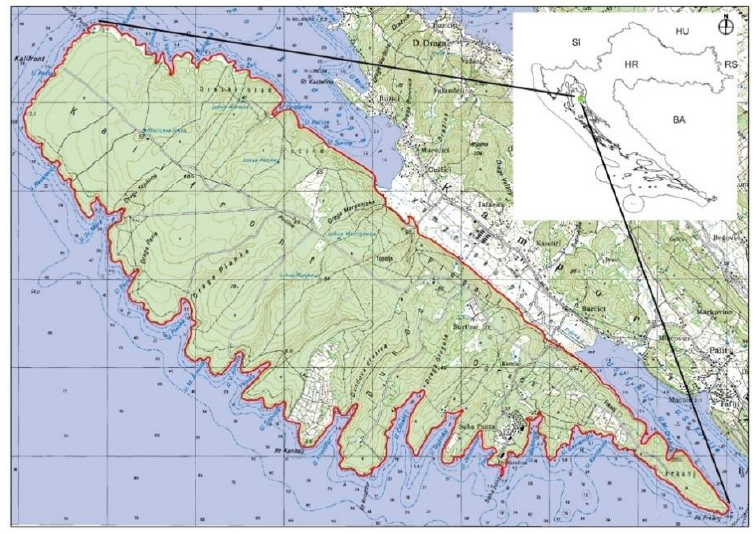
Figure 1. Map of the study area.